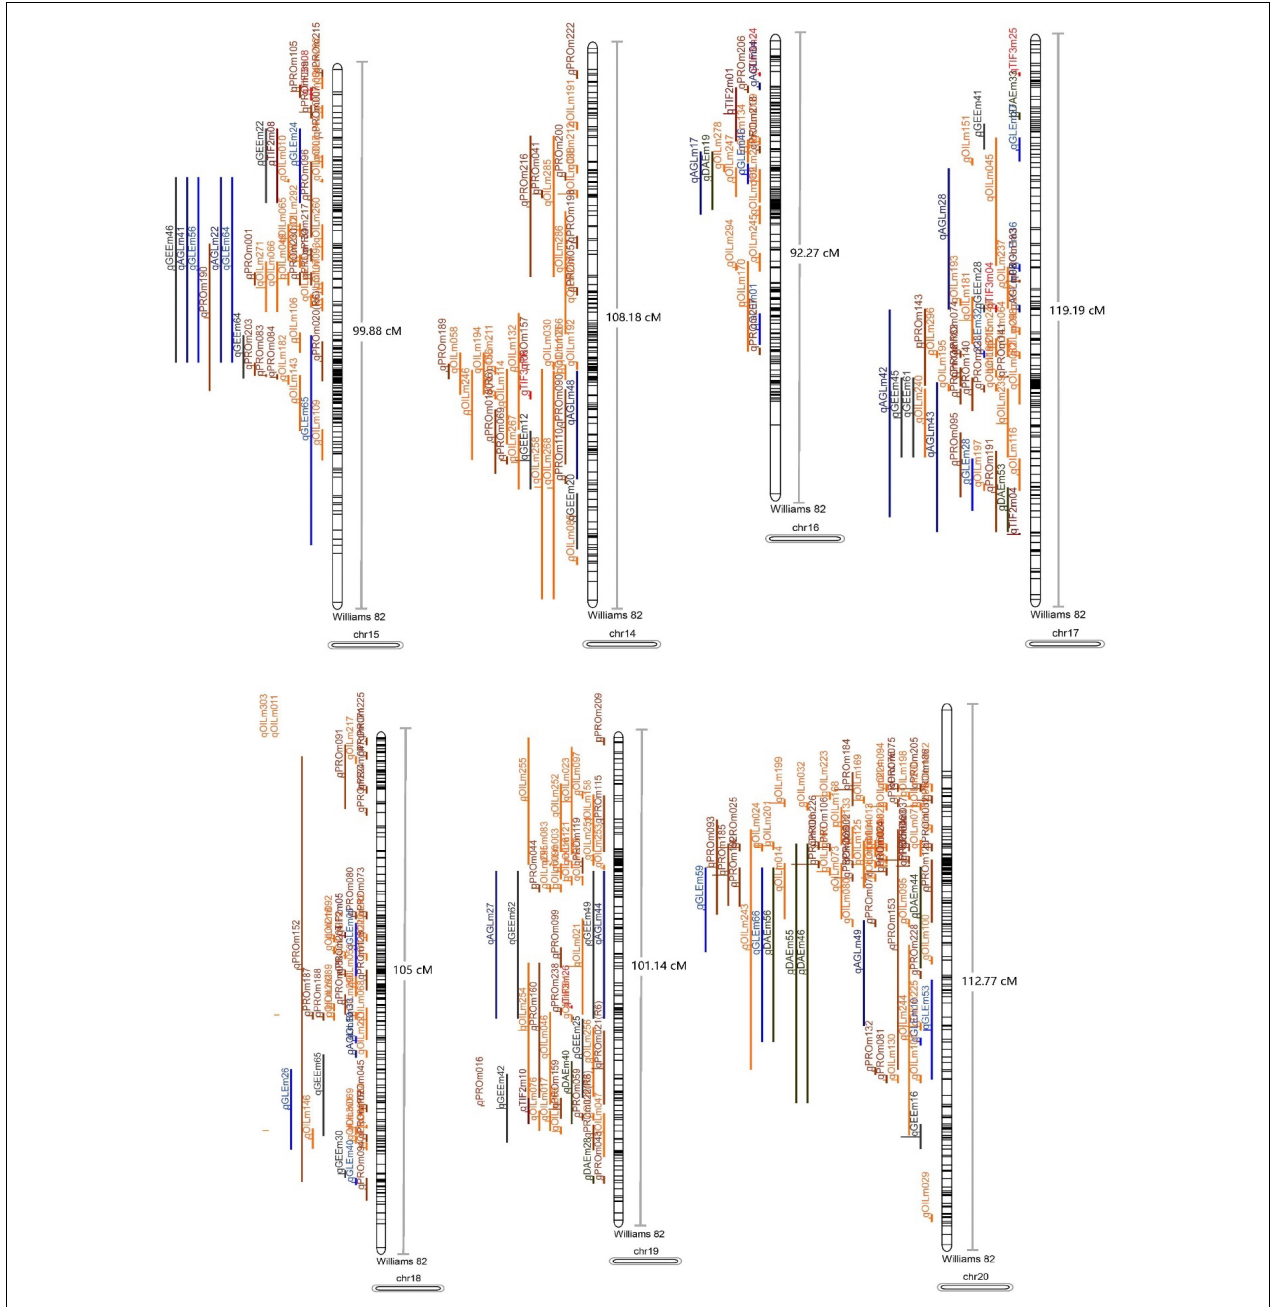
FIGURE 8 | The projection of the QTL collected in this research (the black lines in chromosomes refer to the molecular markers and the other lines refer to the QTL used in